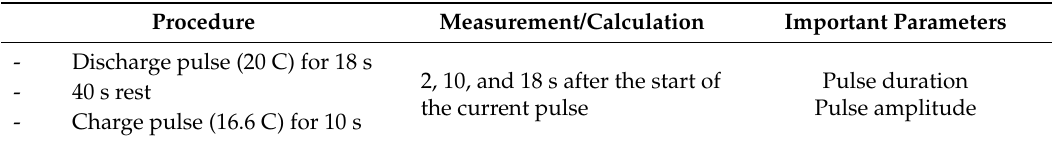
Table 1. VDA (Verband der Automobilindustrie) current step method